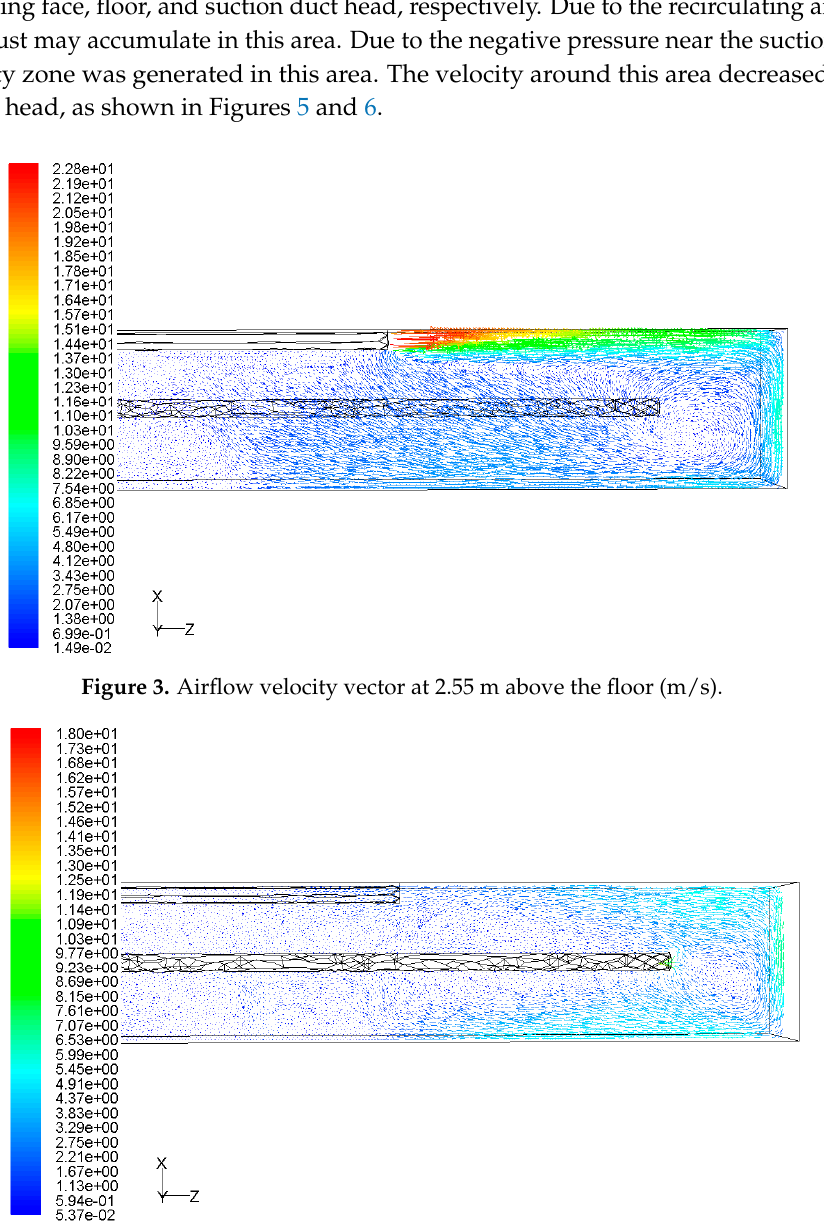
Figure 4. Airflow velocity vector at 1.5 m above the floor (m/s).